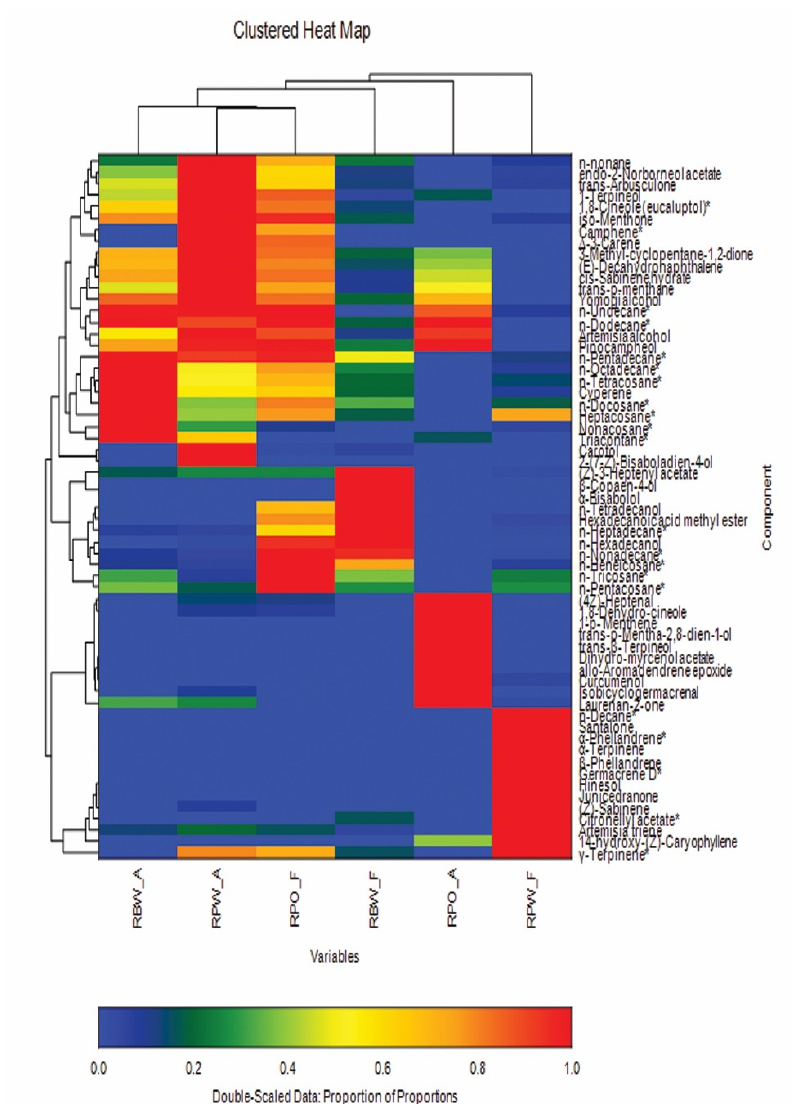
Figure 2. Clustered heat map showing the volatile components of the six studied Rosa samples. A heat map was constructed using Euclidean distance and the unweighted group method. Compounds with % composition of at least 1% were included. [RBW ( Rosa banksiae var. banksiae Ait.), RPO ( Rosa polyantha Thunb. “orange fairy”), RPW ( Rosa polyantha Thunb. “white fairy”), A (aerial parts), F (Flowers)]